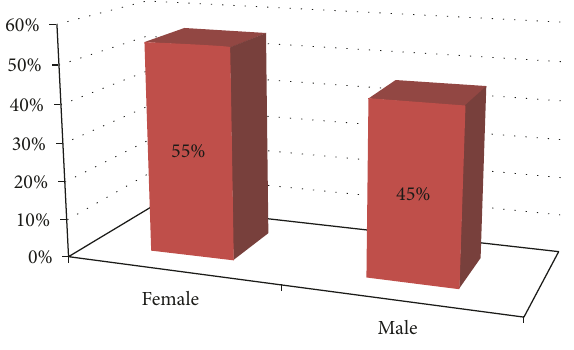
Figure 2: PD patients by gender.